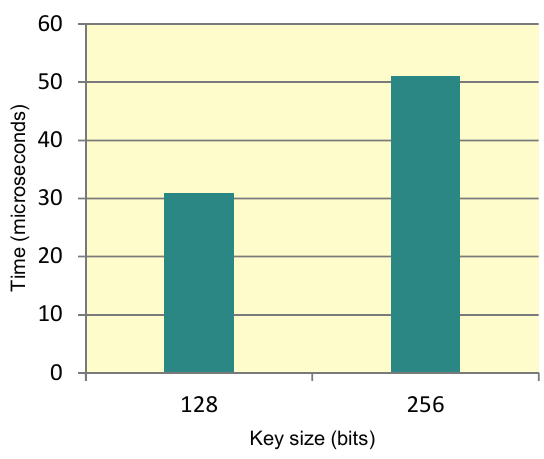
Figure 9. Execution times for ICMetric based AES variants.